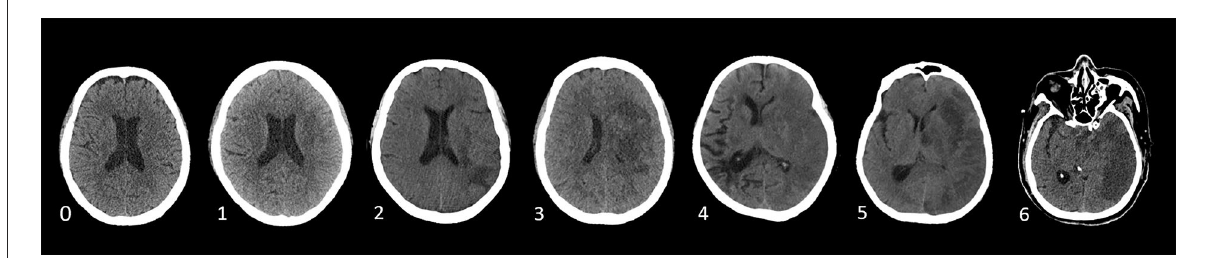
FIGURE2 Swelling Score (0 score illustrates no swelling; a score of 1 indicates the disappearance of cortical sulci; a score of 2 implies minor effacement of the ipsilateral lateral ventricle; a score of 3 indicates the complete disappearance of the ipsilateral lateral ventricle; a score of 4 indicates the disappearance of the third ventricle; a score of 5 illustrates the shift away of the midline; and a score of 6 indicates the disappearance of basal cisterns)